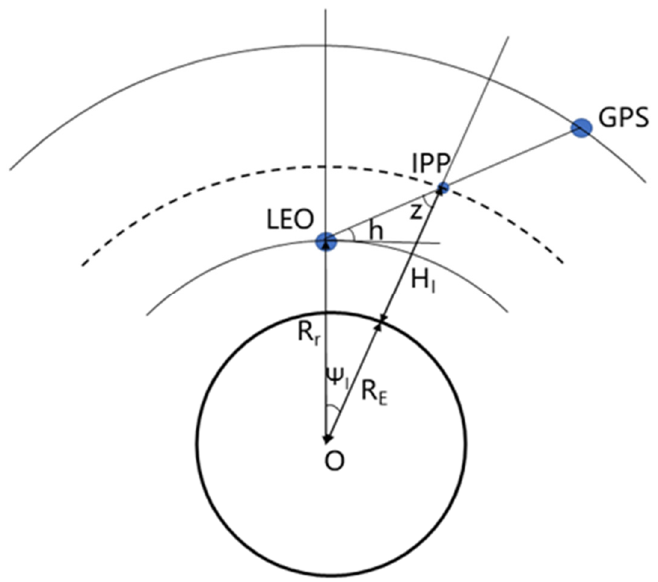
Figure 1. Diagram of topside GPS observations of LEO satellite and the single layer plasmasphere hypothesis